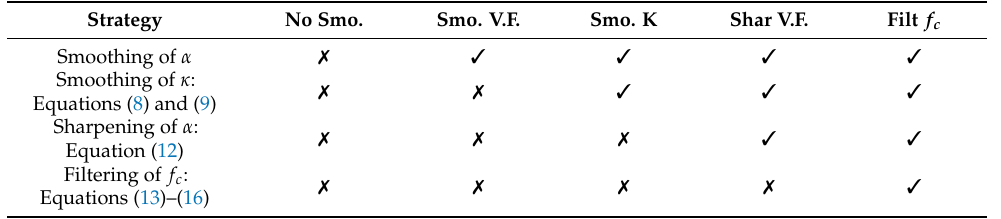
Table 1. Names of different